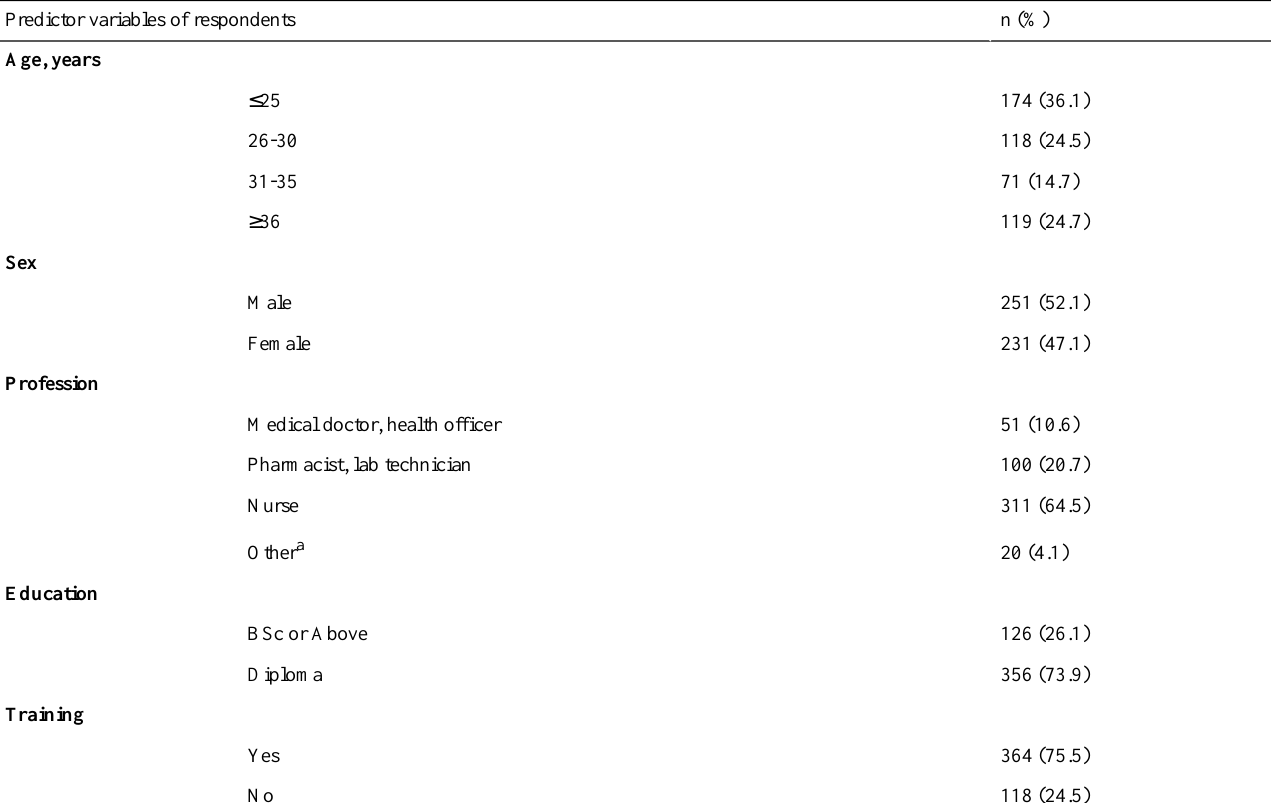
Table 1. Sociodemographic characteristics of